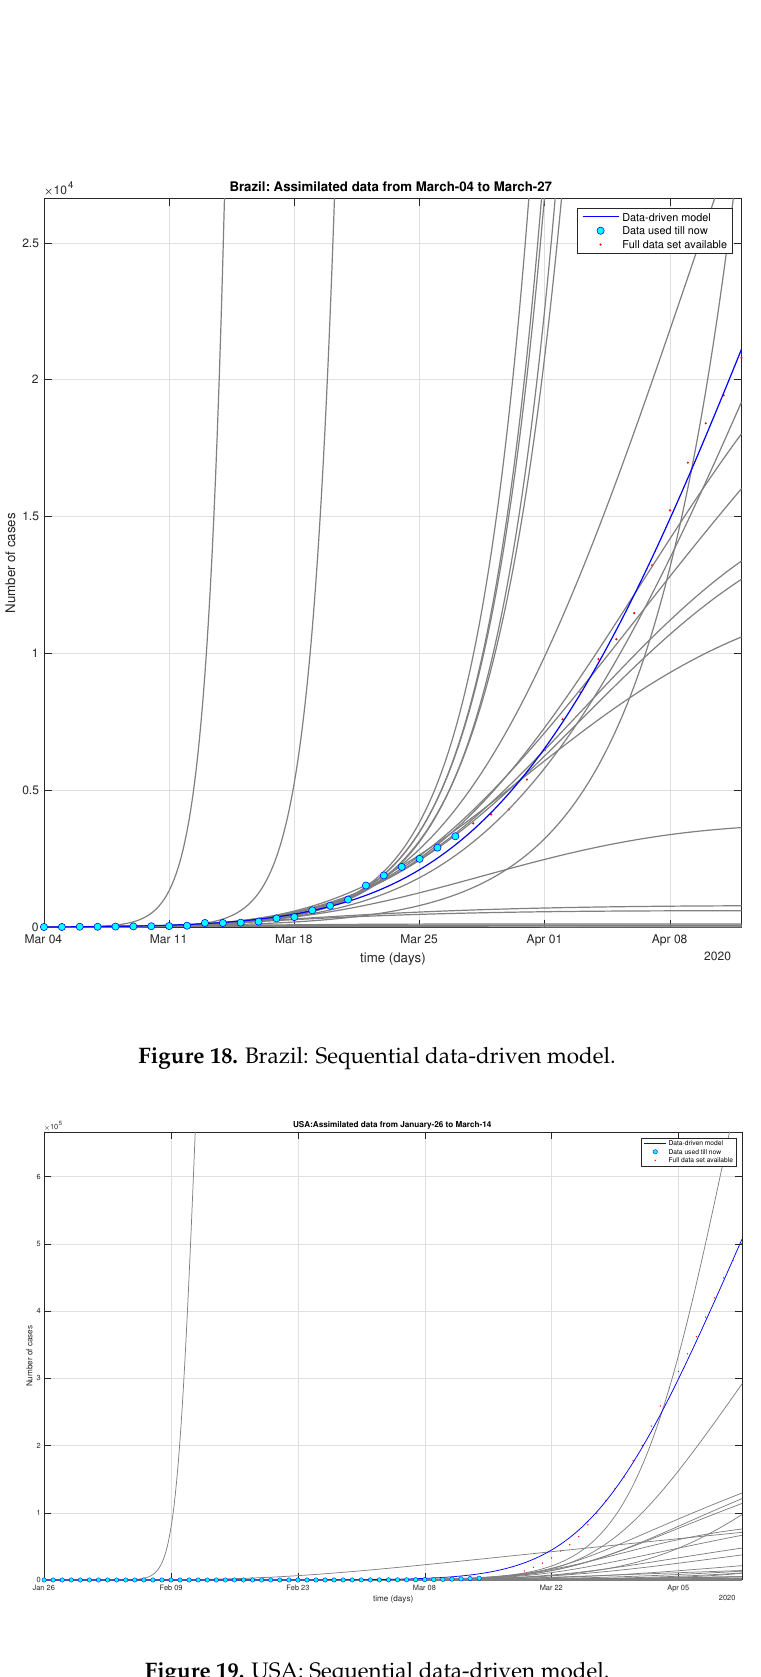
Figure 19. USA: Sequential data-driven